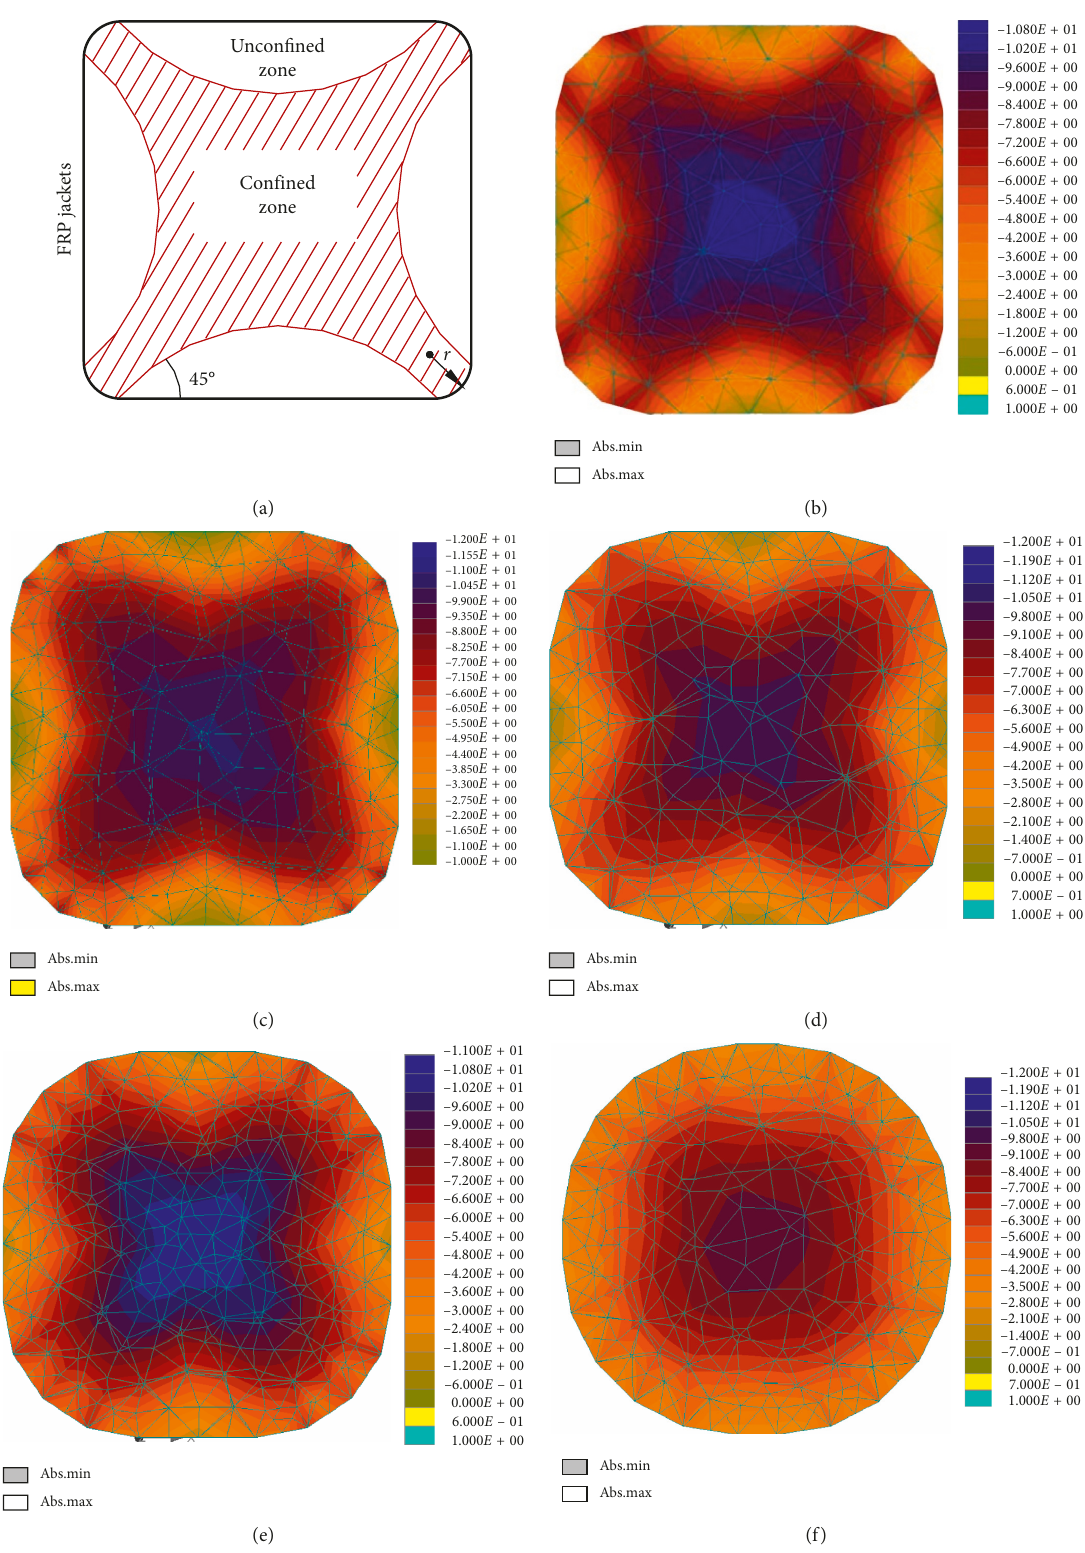
Figure 5: Stress distribution in MPa at peak loads in square columns with different corner radii. (a) Theoretical model. (b) r � 30mm. (c) r � 50mm. (d) r � 60mm. (e) r � 70 mm. (f) r �